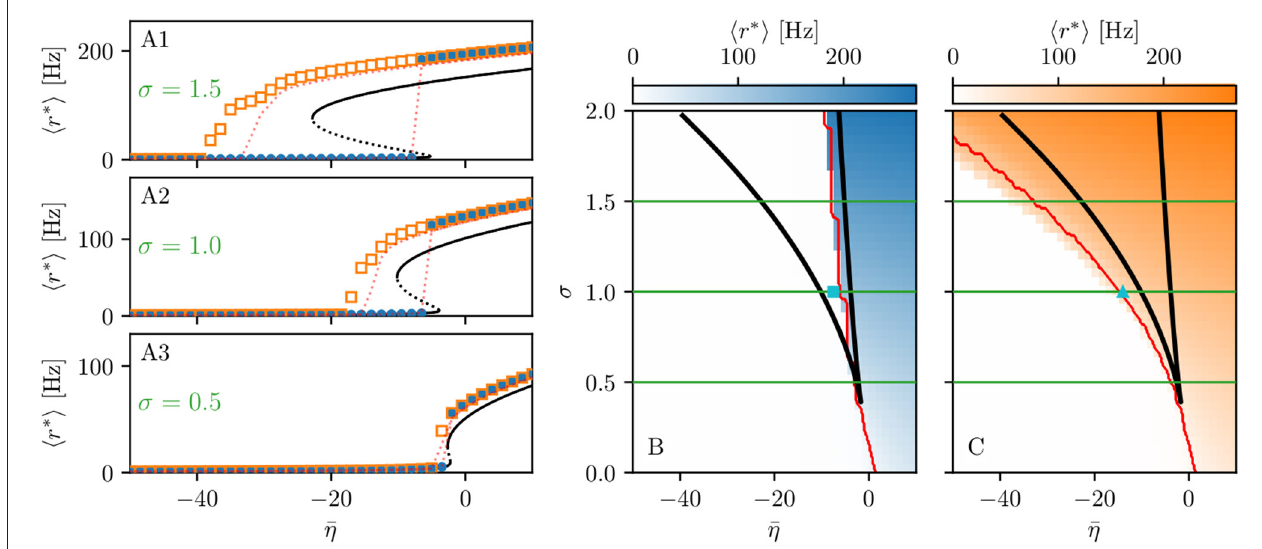
r * η for the up sweep (blue dots) and down-sweep (orange squares). vs. FIGURE 8 | Phase and bifurcation diagrams for patient E6. (A1–A3) Equilibrium firing rates ¯ (cid:11) (cid:10) η η For each [ 50,10] in steps of 1 1.5, the system is initialized using the final state of the previous run and evolves for 2 s after which the average network firing ¯ ∈ − ¯ = rate in the equilibrium state is determined. Different panels correspond to different σ values: σ 1.5 (A1) , σ 1 (A2) , and σ 0.5 (A3) . The solid (dashed) black line = = = corresponds to the stable (unstable) equilibria in the single-node case. The dotted red line depicts the results for the healthy subject H1 reported in Figure 1 . Maps of r * η showing the network average regimes as a function of σ and color-coded for up- (B) and down-sweep (C) , obtained by following the same procedure as in ¯ (cid:10) (cid:11) (A1–A3) for σ [0,2] in steps of 1σ 0.05. The black line indicates the single-node map of regimes like in Montbrió et al. (2015). The red solid line indicates the ∈ = η boundaries of the map of regimes previously as shown in Figure 1 for the healthy subject H1. In (B,C) the cyan square and triangle mark 7.5, 14, respectively. ¯ = − − k l Parameter values: N pop 88, τ m 20 ms, 1 1, J kk 20, J kl 5 ˜ J kl , = = = = = ∀ 6=